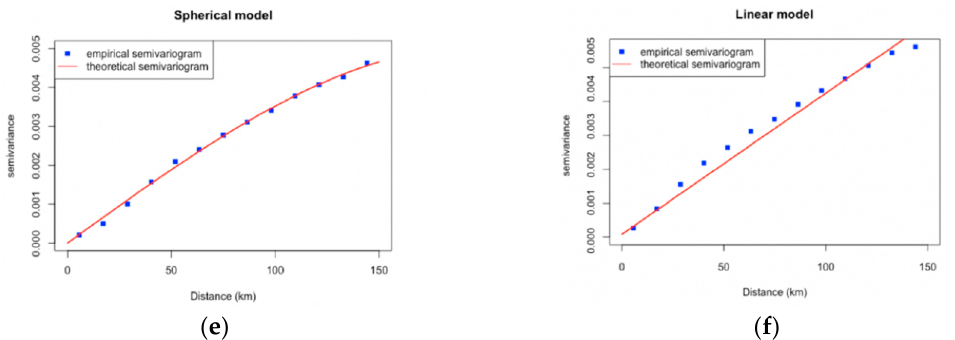
Figure 4. The set of semivariogram models used in our analysis. In particular, Exponential model ( a ), Gaussian model ( b ), Circular model ( c ), Wave model ( d ), Spherical model ( e ) and Linear model ( f) . The figure also exemplifies the best fitting procedure we use to select, case-by-case, the optimal semivariogram.